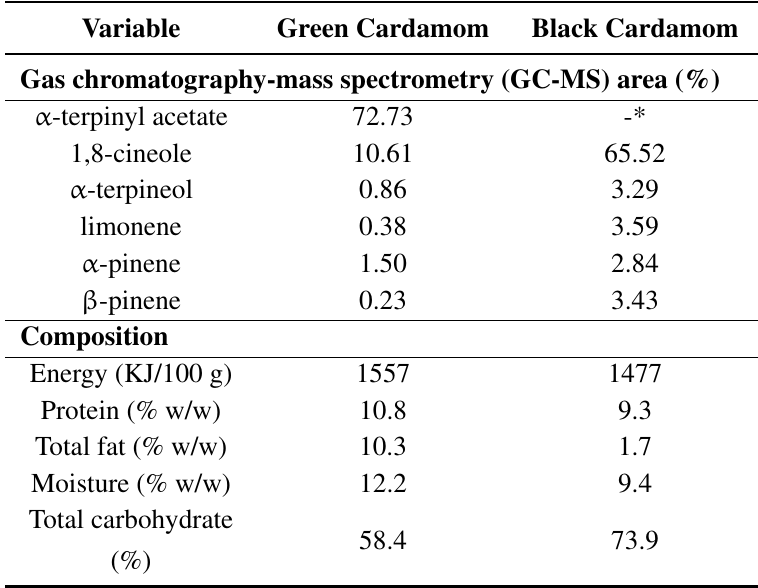
Table 2. Cardamom